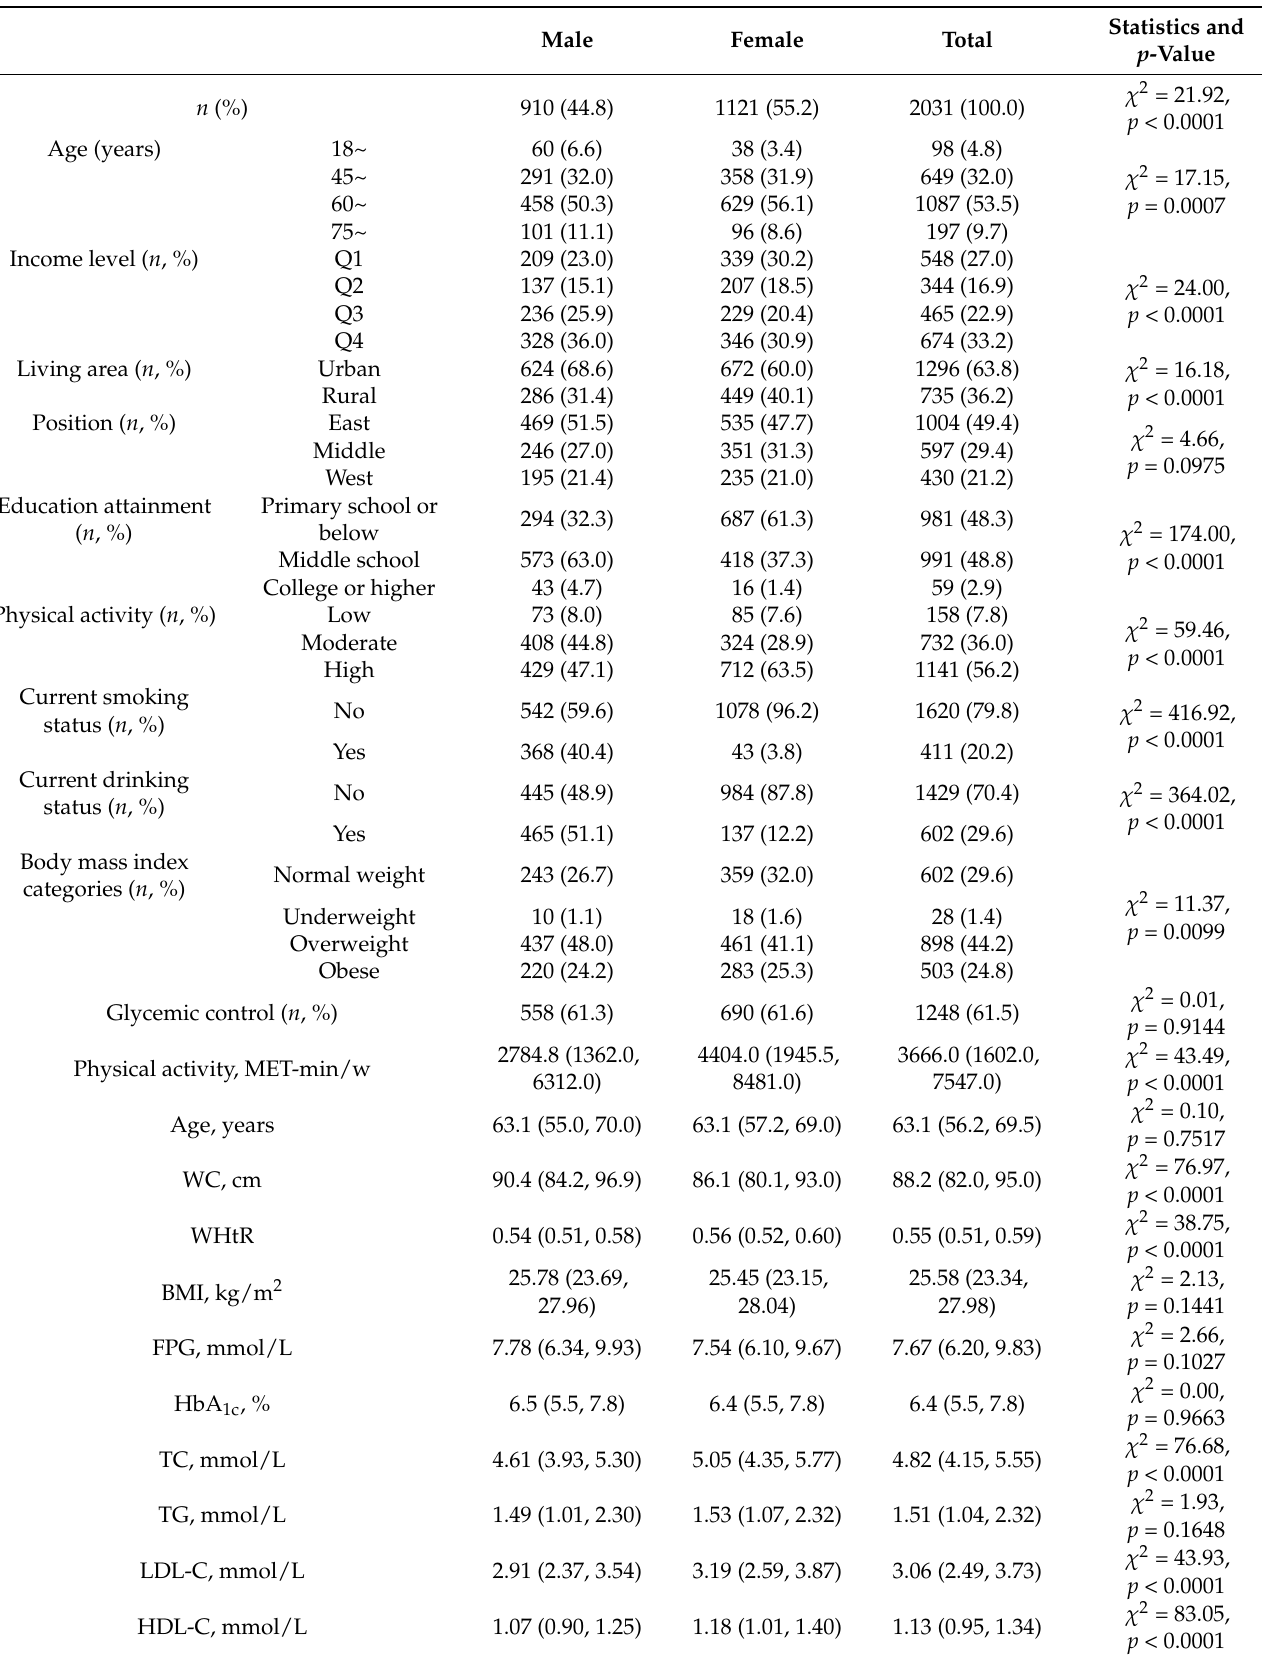
Table 1. Demographic and clinical characteristics of study participants ( n =